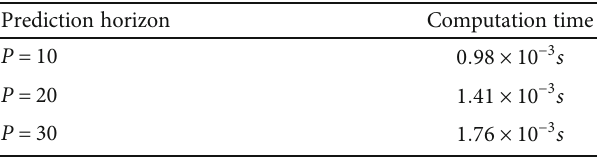
Table 3: Computation time in di ff erent prediction horizons. Prediction